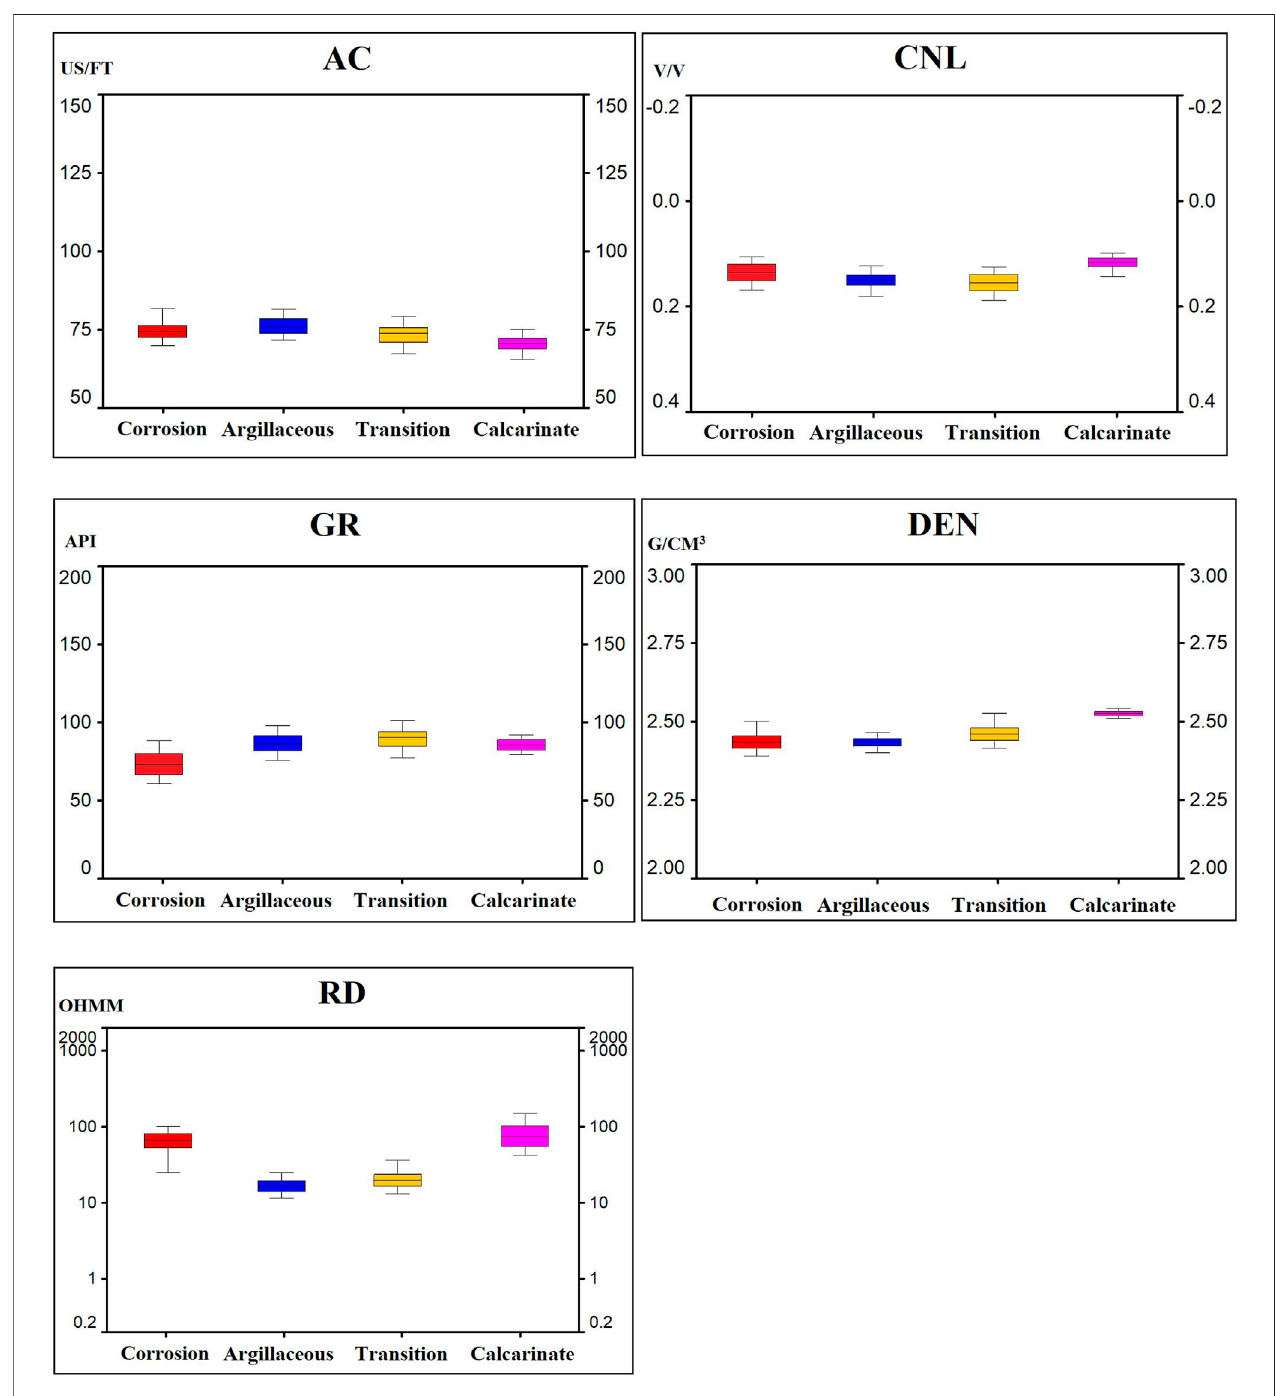
FIGURE 8 | Logging response box diagram of different petrophysical facies in the Es 3 reservoir.